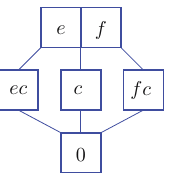
Figure 7: The eggbox of Θ